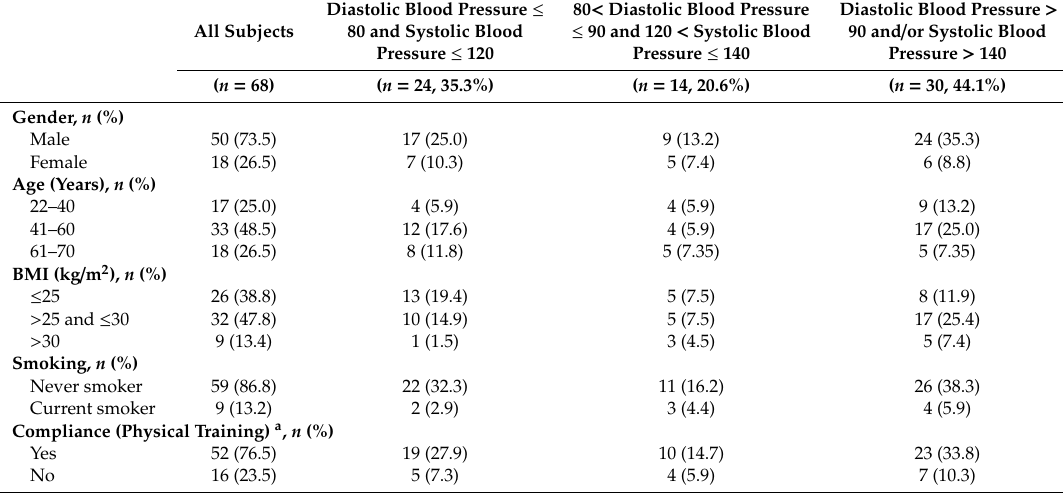
Table 1. Characteristics of the Study Participants at the Baseline (T0).